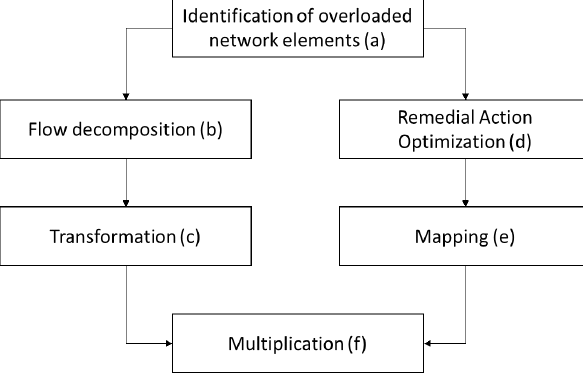
Figure 1. Flow chart of cost sharing